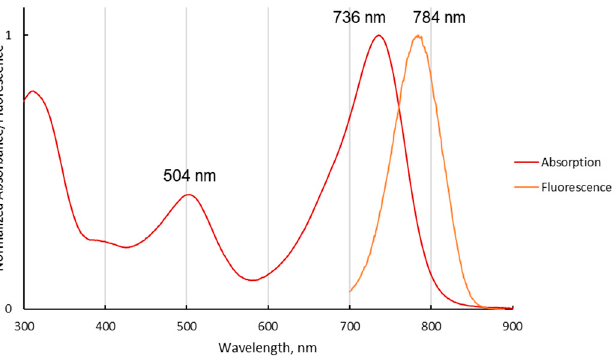
Figure 1. Normalized absorption (red) and emission (orange) spectra of BD in DCM. The excitation wavelength is 680 nm.